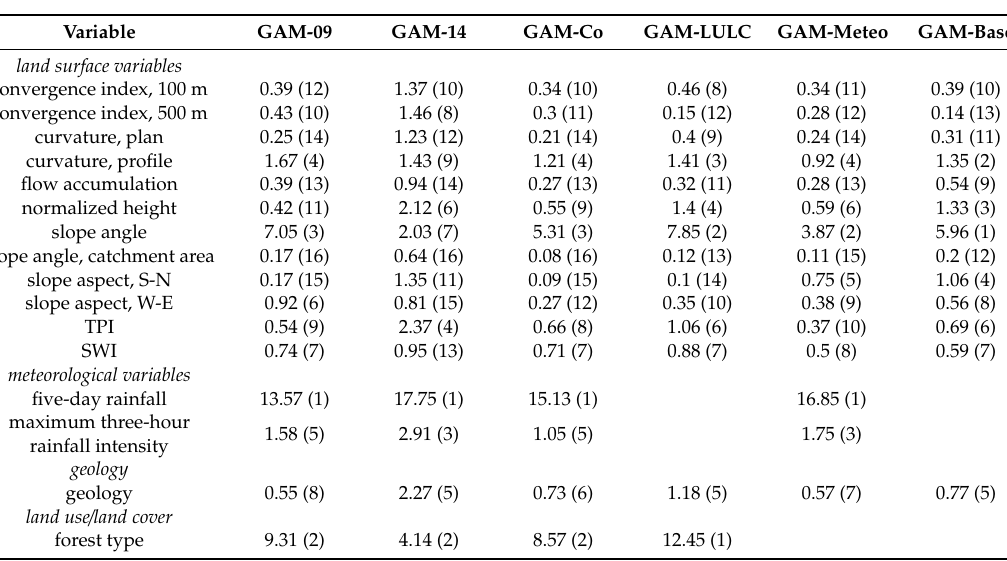
Table A7. Variable importance.